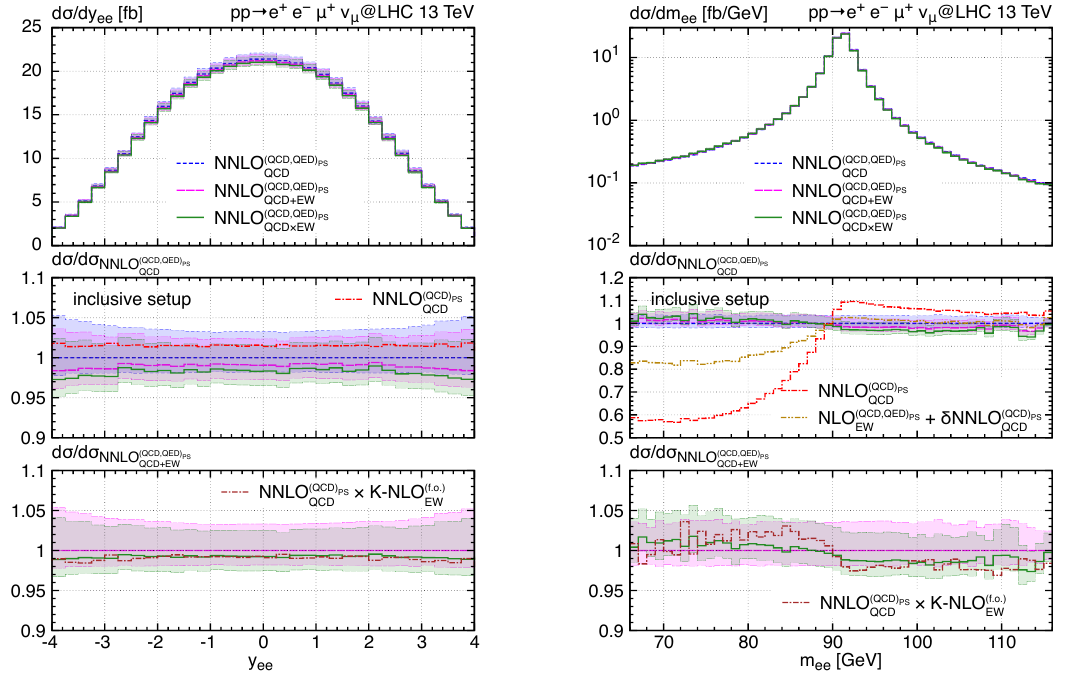
Figure 4. Differential distributions of the dilepton rapidity originating from the Z-boson (left) and of the corresponding dilepton invariant mass (right) in W + Z production in the inclusive setup at NNLO QCD combined with NLO EW matched to parton showers for different combination schemes. See text for